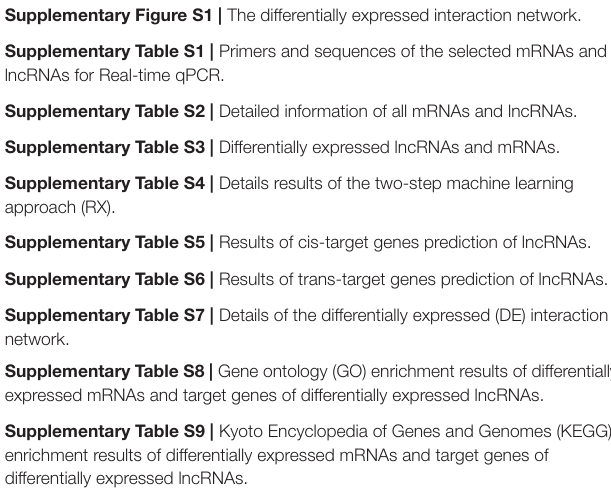
Supplementary Figure S1 | The differentially expressed interaction network.